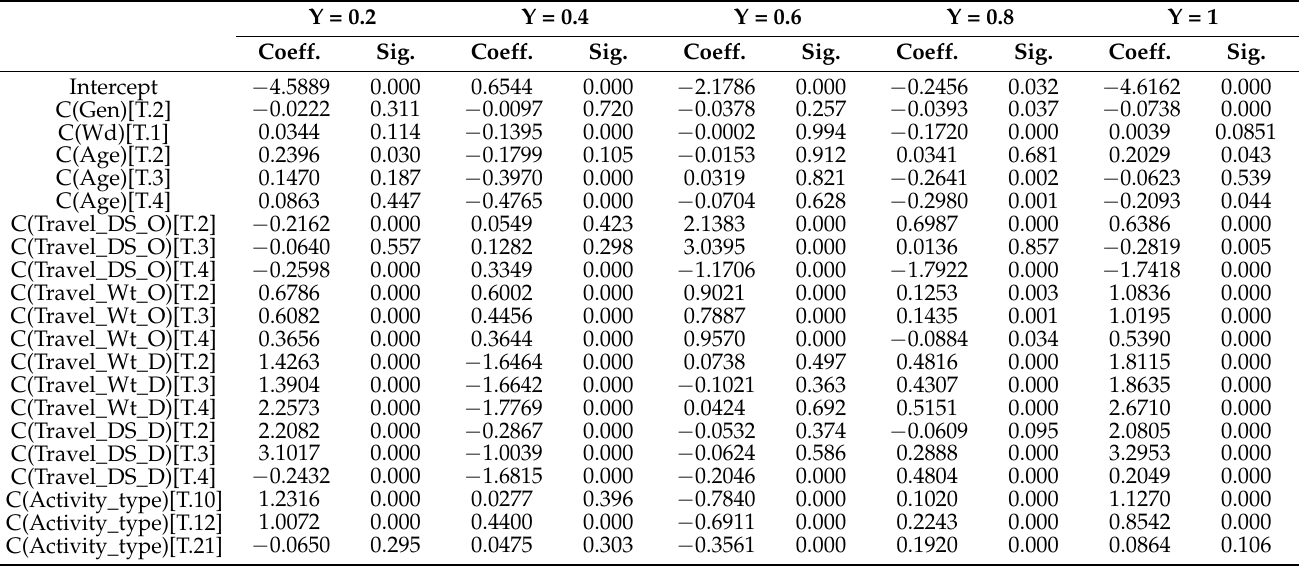
Table 10. Simulation results of multinomial logit model (May 2019).